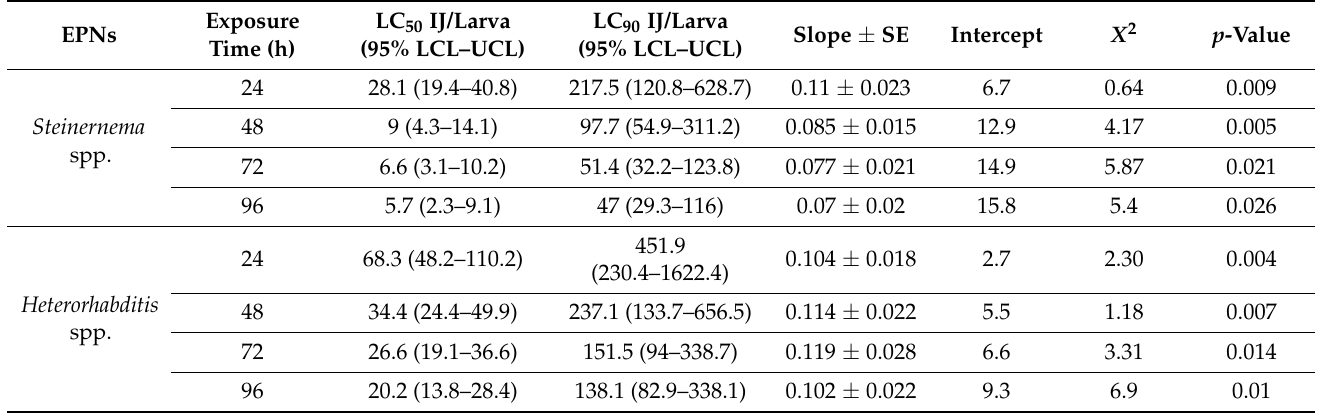
Table 4. Pathogenicity of two EPNs against the carob moth, Ectomyelois ceratoniae .